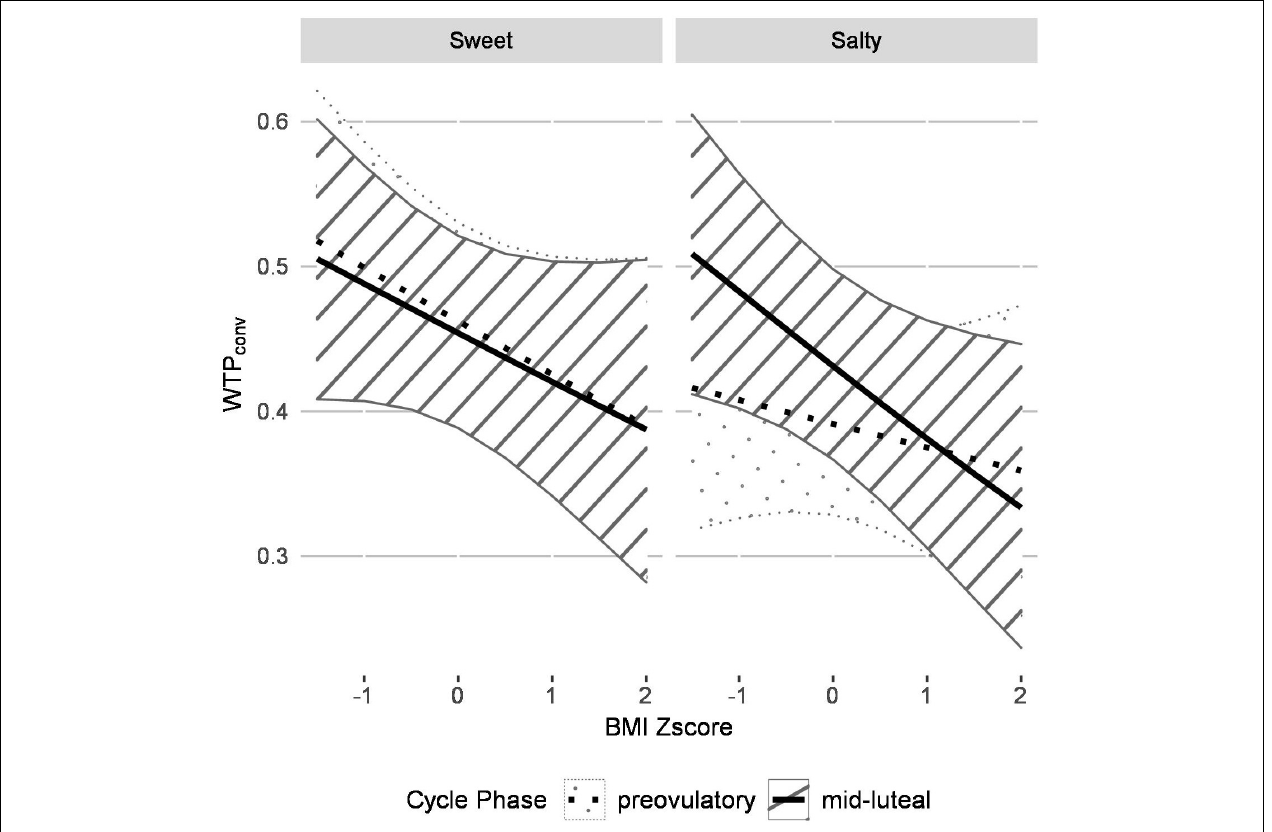
FIGURE 3 | The generalized linear mixed model (GLMM) reveals that the relationship between WTP conv is inversely related to BMI for both sweet and salty snacks and menstrual cycling affects WTP conv for salty, but not for sweet, snacks. The plot visualizes how cycle phase, taste and BMI interact to predict WTP conv according to the GLMM. WTP conv is inversely related to BMI and the strength of this relationship depends on cycle phase and taste. For sweet food items, average pre-ovulatory and mid-luteal WTP conv both decrease with increasing BMI and the GLMM only predicted a slight difference between cycle phases. For salty food items, higher average WTP bids are predicted in the mid-luteal compared to the pre-ovulatory cycle phase for participants with low BMI whereas this effect diminishes with increasing BMI. Control analyses verified that the overall effect was reflected in the data of the individual